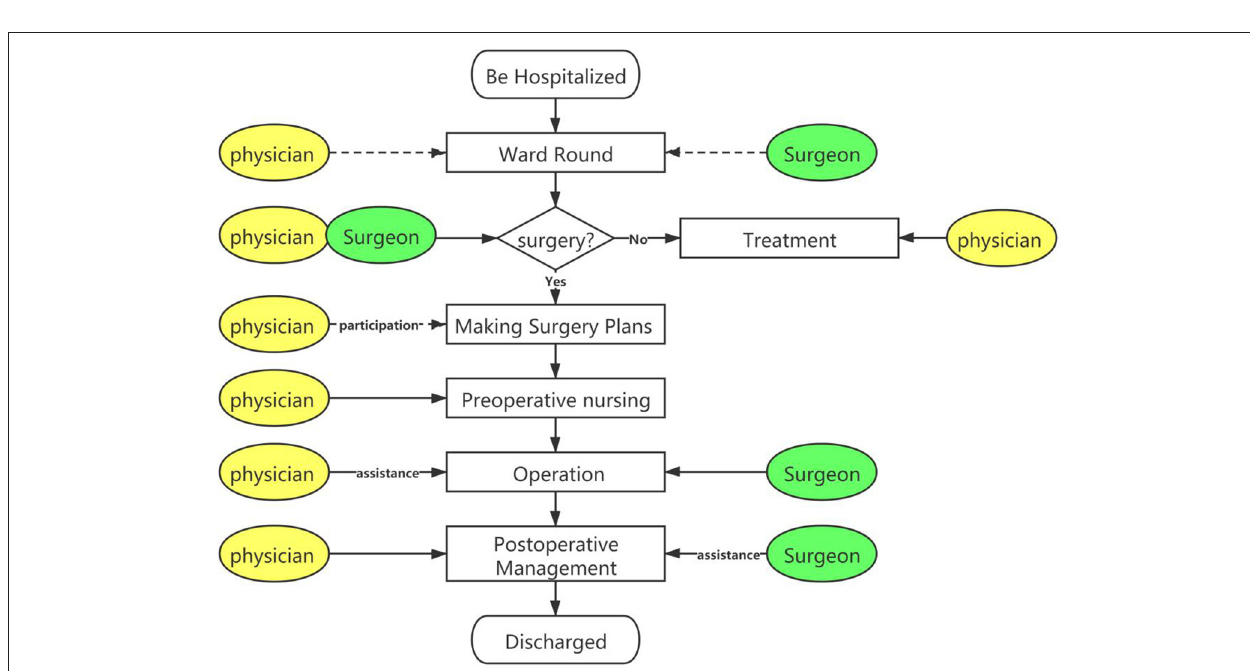
FIGURE 2 | “One-station” inpatient